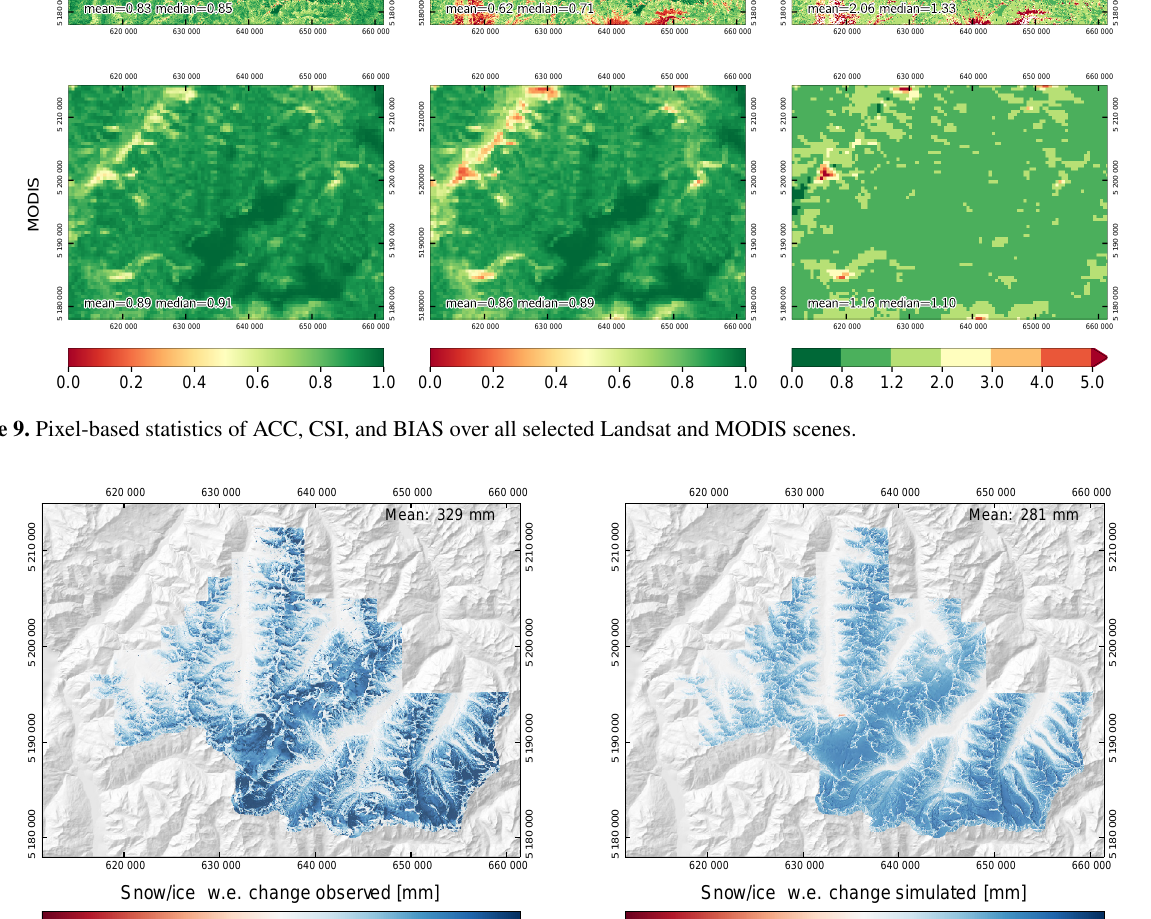
tional increase by 15 %) and the topographic snow redistri- bution; see Eq.